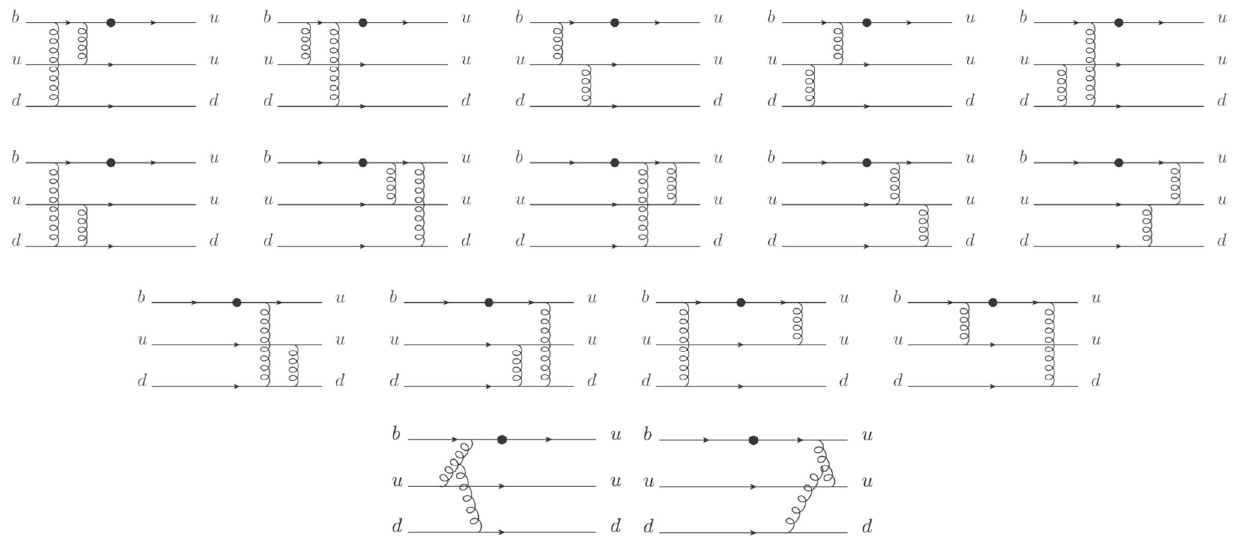
Fig. 1 Feynman diagrams for the (cid:2) b → p transition form factors, where the black dots denote the weak interaction vertices. These diagrams are labelled by D 1 , D 2 ,... and D 16 in sequence in the